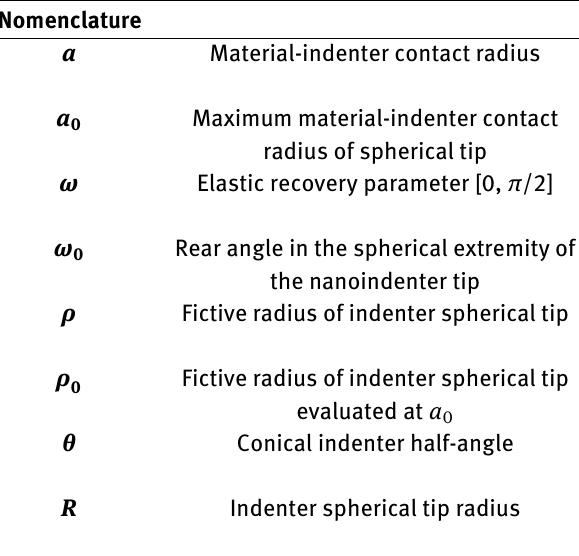
Table 2: Nomenclature appearing in the